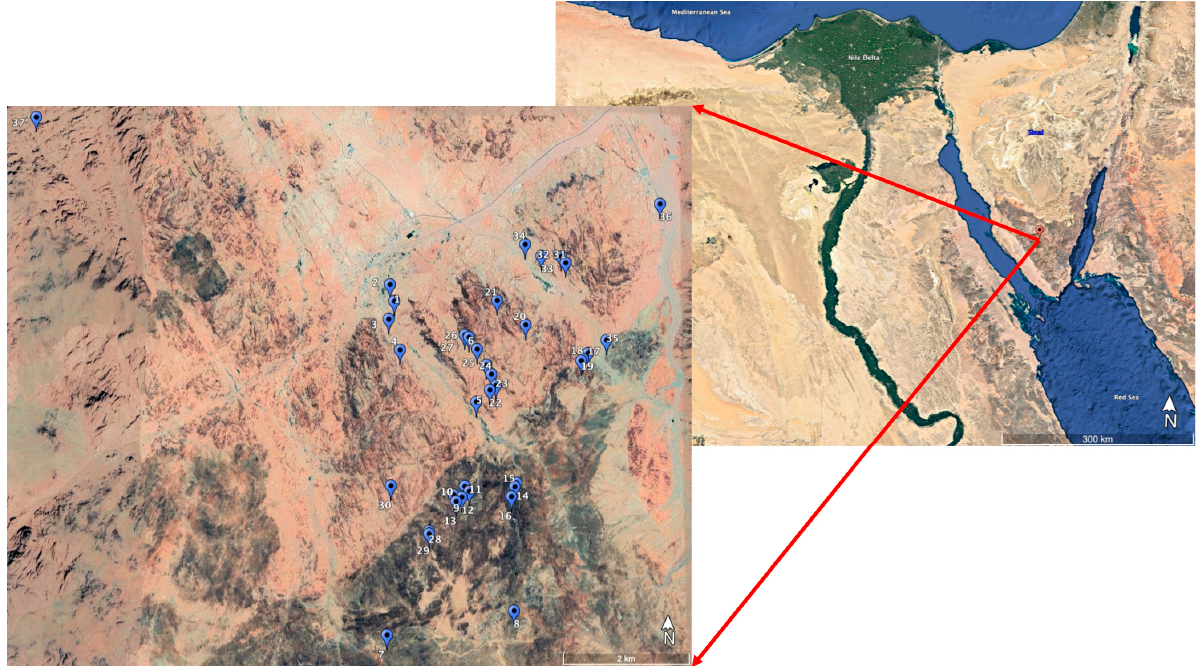
Figure 1. Location map of the 37 enclosures (1–37) located in the South Sinai mountainous region, Saint Katherine, Egypt (prepared from Google Earth). Table 1. Characteristics of the 37 enclosures in the South Sinai mountainous region (Saint Katherine, Egypt). Enclosure No.